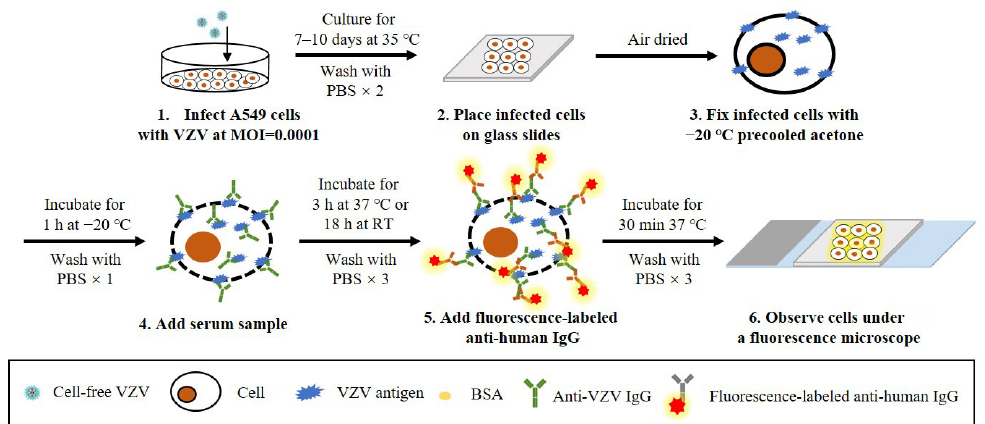
Figure 4. Schematic diagram of the protocol of a reported IFAT for the detection of anti ‐ VZV anti ‐ bodies. (1) Human lung carcinoma cells (A549) are infected with VZV at MOI = 0.0001 and cultured for 7 – 10 days at 35 °C. (2) After washing, the infected cells are placed on glass slides and air ‐ dried. (3) Cells are fixed with precooled acetone for 1 h at − 20 °C. (4) After washing, diluted serum samples are added and incubated for 3 h at 37 °C or for 18 h at room temperature (RT). (5) After washing, fluorescence ‐ labeled anti ‐ human IgG is added and incubated for 30 min at 37 °C. (6) After washing, the stained cells are observed under a fluorescence microscope.